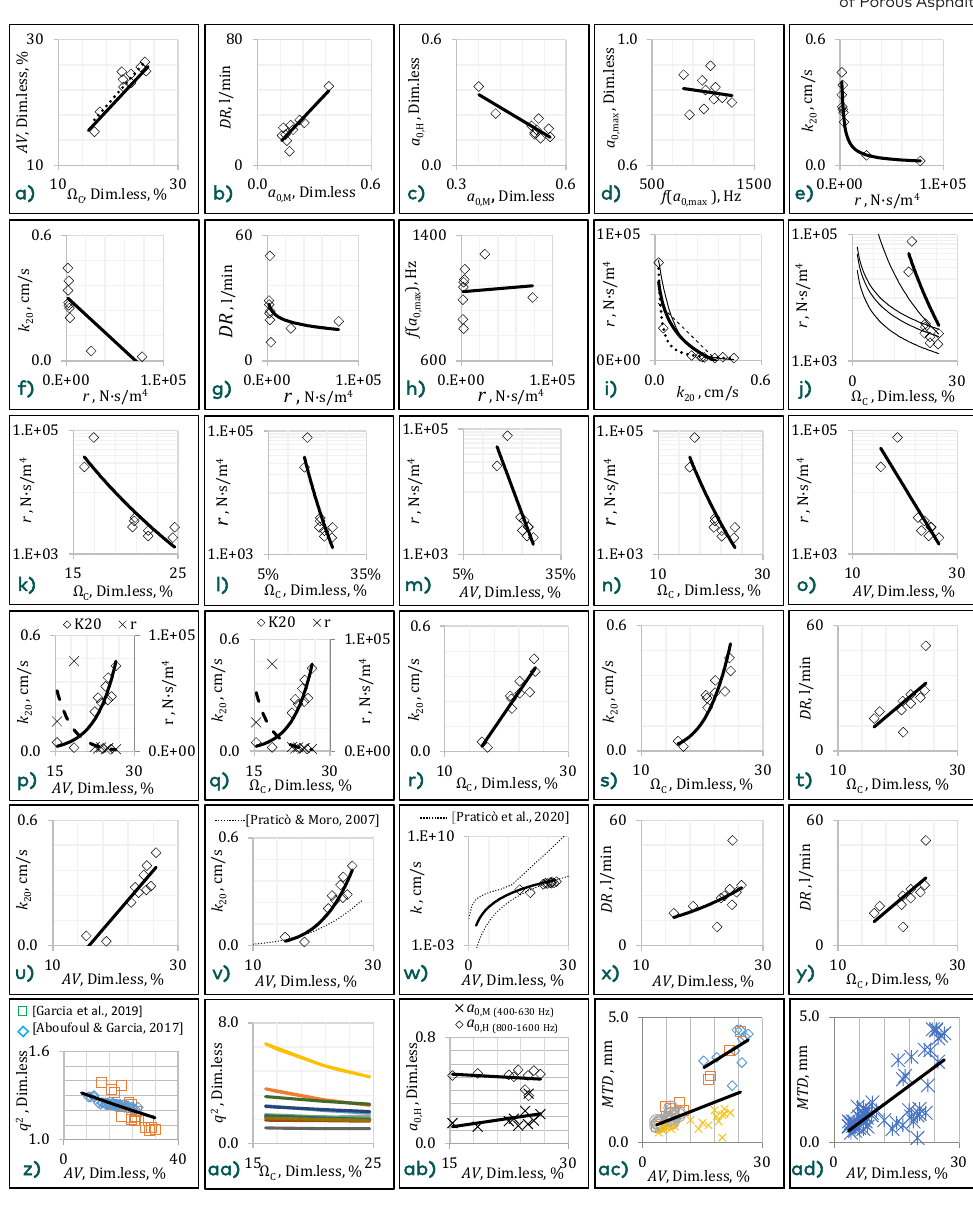
Figure 3. Volumetric, functional, and acoustic